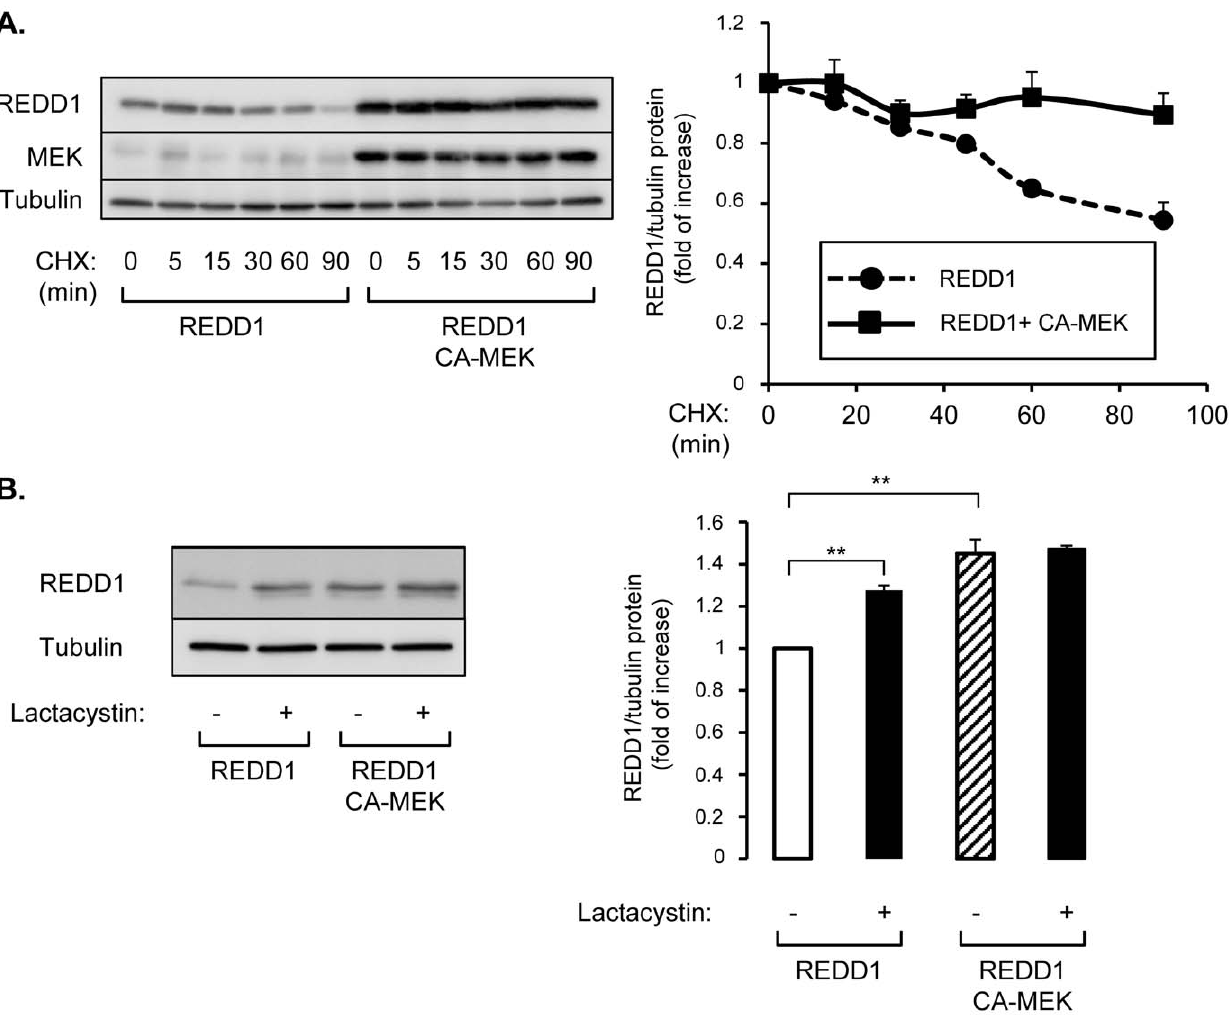
Figure 4. Expression of constitutive active MEK inhibits REDD1 degradation. (A) HEK-293 cells were transfected with plasmids encoding for REDD1 in absence or in presence of a plasmid encoding for constitutive form of MEK (CA-MEK). 48 h after transfection, wells were treated with cycloheximide (CHX 10 m g/ml) for the indicated periods of time, and proteins were analyzed by immunoblots with indicated antibodies. REDD1 protein level is expressed compared to tubulin expression and quantification of three independent experiments is shown. (B) HEK-293 cells were transfected with plasmids encoding for REDD1 in absence or in presence of a plasmid encoding for a constitutive form of MEK (CA-MEK). 48 h after transfection, cells were treated with lactacystin (10 m M) for 5 hours. Proteins were analyzed by immunoblots with indicated antibodies. Quantification of three independent experiments is shown and REDD1 protein level is expressed compared to tubulin expression (**p , 0.01).